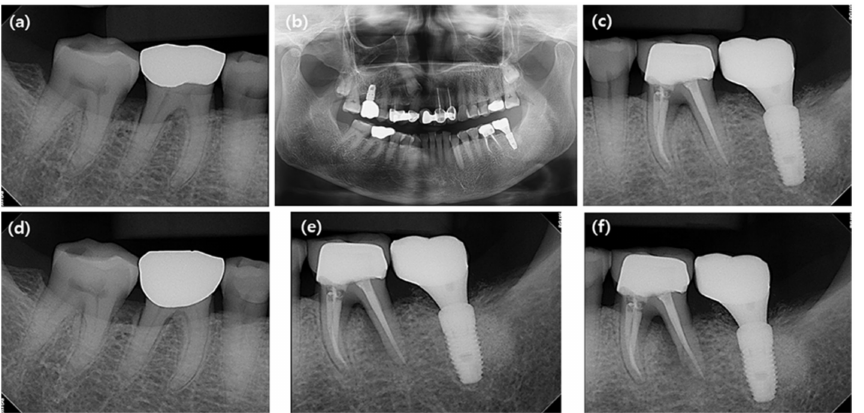
Figure 2. Radiographic measurement. ( a ) A periapical radiograph of the mandibular first molar (MnM1) adjacent the mandibular second molar (MnM2) at baseline. ( b ) A panoramic radiograph at baseline. ( c ) A periapical radiograph of MnM1 adjacent to the single implant placed in the mandibular second molar site (ImM2) at baseline. ( d ) A periapical radiograph of MnM1 adjacent MnM2 at the last follow-up. ( e ) A periapical radiograph of MnM1 adjacent to ImM2 at 3-year follow-up after prosthesis delivery of ImM2. ( f ) A periapical radiograph of MnM1 adjacent to ImM2 at the last